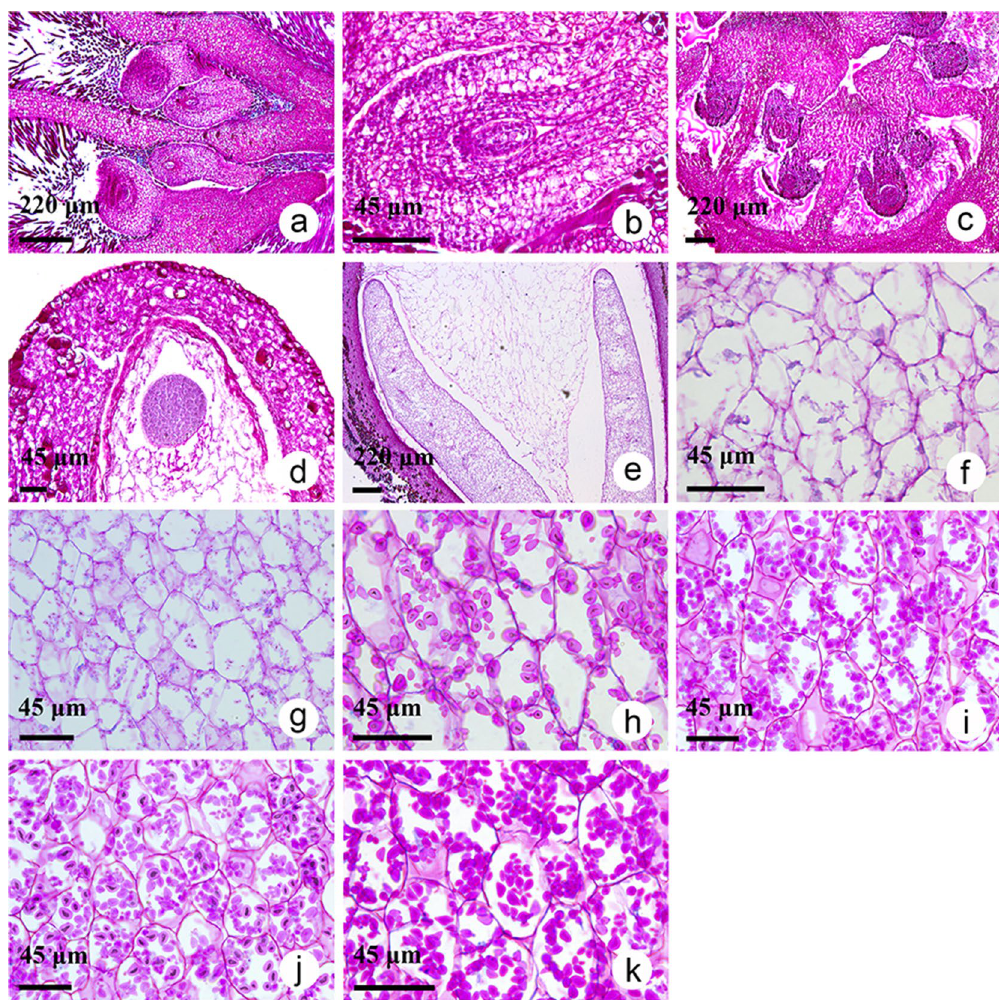
Figure 2. CCSK at various developmental stages stained with PAS. ( a ) Longitudinal section of ovary at 10 days after flowering (DAF). ( b ) Longitudinal section of ovule at 20 DAF. ( c ) Transverse section of ovary at 30 DAF. ( d ) Globular proembryo stage, 40 DAF. ( e ) Cotyledon at 50 DAF. ( f ) Cotyledon at 50 DAF. ( g ) Cotyledon at 60 DAF. ( h ) Cotyledon at 70 DAF. ( i ) Cotyledon at 80 DAF. ( j ) Cotyledon at 90 DAF. ( k ) Cotyledon at 100 DAF. Scale: a , c , e = 220 μm; b , d , f , g – k = 45